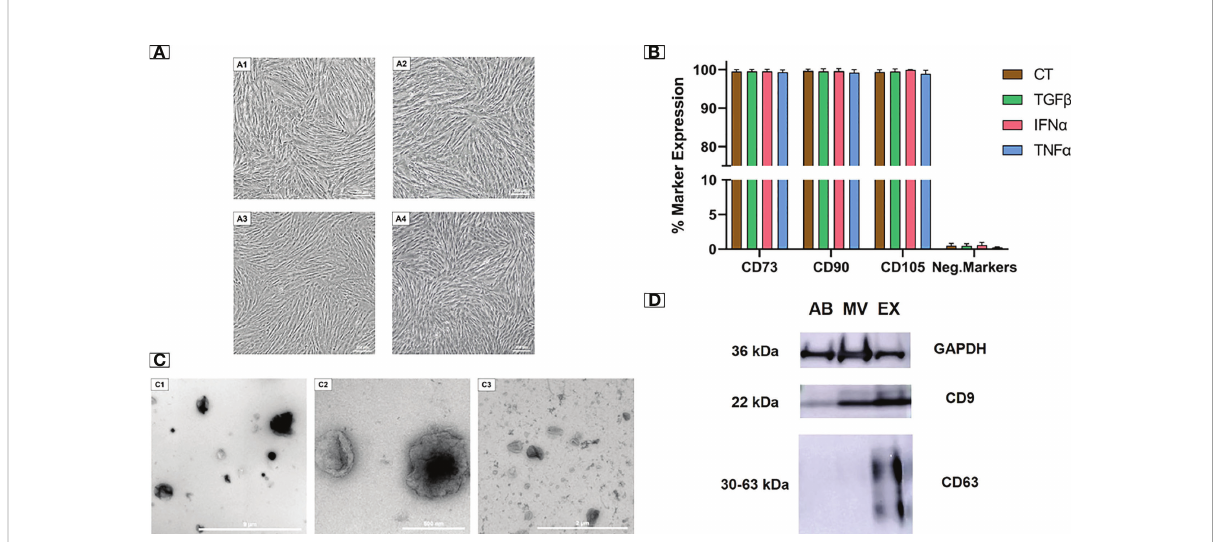
FIGURE 1 Cytokine-primed UCMSCs and their EVs expressed typical morphology and molecular markers. (A1 - A4) Typical morphology of (A1) non- priming UCMSCs; (A2) TGF b -primed UCMSCs; (A3) IFN a -primed UCMSCs; (A4) TNF a -primed UCMSCs; were captured under Nikon Inverted Microscope Eclipse Ti-S at day 5 of P5. (B) Expression of MSC markers (n = 3) was analyzed using the fl ow cytometry approach. (C1 - C3) Morphology of different EV populations was observed under TEM. (C1) An AB representative with a diameter ranging from 500 nm to 2000 nm (scale bar 9 m m); (C2) A MV representative with irregular shapes and diameters from 200 nm to 400 nm (scale bar 500 nm); (C3) An EX representative that has cup-shaped morphology and sizes ranging from 40 to 200 nm (scale bar 2 µm). (D) A representative of EV markers (22). 15 m g total EV protein was loaded in each lane. Internal reference GAPDH and CD9 were detected in all three EV populations. CT, non-priming UCMSCs; TGF b , TGF b -primed UCMSCs; IFN a , IFN a -primed UCMSCs; TNF a , TNF a -primed UCMSCs. Apoptotic Bodies; MV, Microvesicles; EX, Exosomes. All representative images of EVs were obtained from EVs secreted by TGF b -primed UCMSCs. Error bars indicate ±